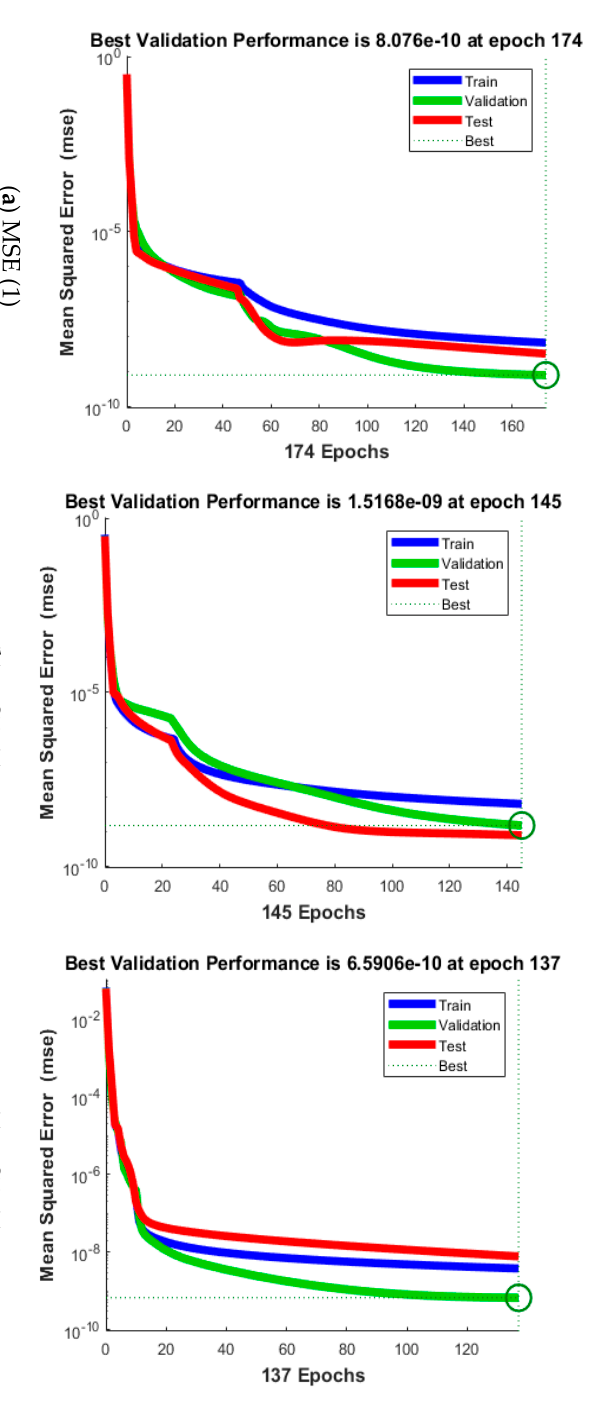
Figure 3. MSE and STs for the FO-MML love story model.